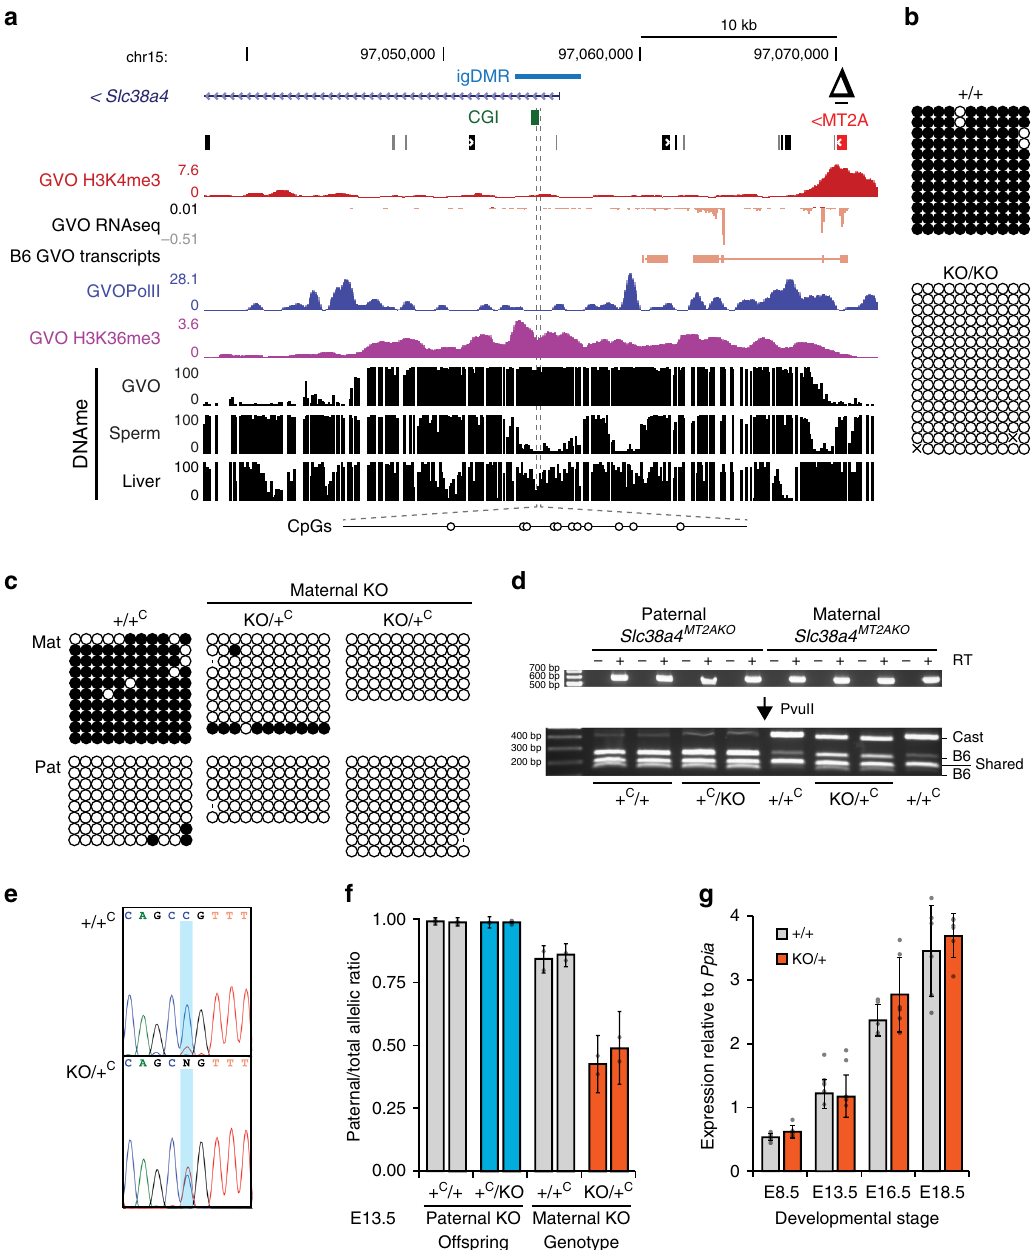
Fig. 5 Loss of imprinting at Slc38a4 upon maternal transmission of the MT2A KO allele. a Genome-browser screenshot of the mouse Slc38a4 promoter and upstream region, including the MT2A LTR (red), annotated Slc38a4 exon 1, CGI (green), and igDMR (blue). GVO RNA-seq as well as RNA pol II, H3K4me3 and H3K36me3 ChIP-seq tracks are shown, along with DNAme data for GVO, sperm and adult liver. The region within the igDMR analyzed by sodium bisul fi te sequencing (SBS), which includes 11 CpG sites, is shown at the bottom. Δ : extent of the MT2AKO deletion allele. b DNAme of the Slc38a4 igDMR in GVO from wild-type and Slc38a4 MT2AKO/MT2AKO females determined by SBS. c DNAme of the Slc38a4 igDMR in E13.5 ( Slc38a4 + /MT2AKO × CAST)F1 embryos determined by SBS. Data for control ( + / + C ) and heterozygous (KO/ + C ) littermates with a maternally inherited MT2AKO are shown. + C : wild-type CAST allele; KO: Slc38a4 MT2AKO . A polymorphic insertion in the ampli fi ed region allows for discrimination of maternal (Mat) and paternal (Pat) strands. Allele-speci fi c expression analyses of F1 E13.5 placental RNA by d RT-PCR followed by PvuII RFLP analysis (RT reverse transcriptase), and e, f Sanger sequencing of a T ⟷ C transition in the 3 ′ UTR of the Slc38a4 cDNA (maternal B6: T allele; and paternal CAST: C allele). Each bar in f shows the mean of individual samples, and error bars show S.D. of two SNPs analyzed. Source data are provided as a Source Data fi le. g Total Slc38a4 mRNA levels in E8.5, E13.5, E16.5, and E18.5 placentae, as determined by RT-qPCR ( n = 6 biologically independent samples for each datapoint). Expression levels are relative to the housekeeping gene Ppia . Graph shows mean ± S.D. Source data are provided as a Source Data fi